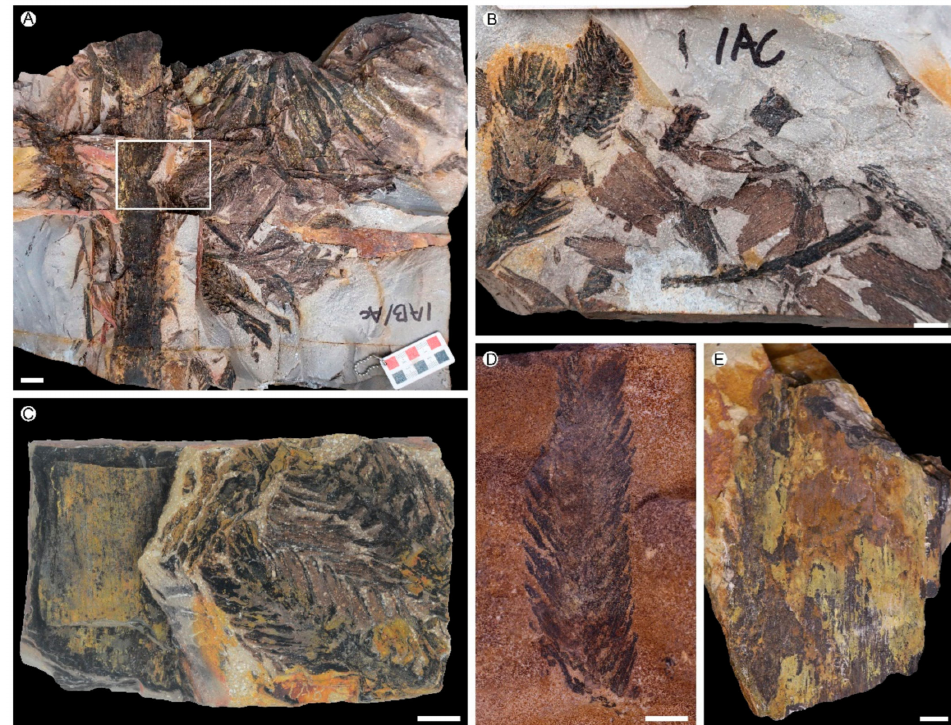
Figure 3. Tingia unita from Wuda Coalfield, Inner Mongolia. ( A ) Overall morphology of T. unita , both compound leaves and strobili are directly attached on the same stem, scale bar = 2 cm. ( B ) showing the large pinnules and stribilus, scale bar = 1 cm. ( C ) Enlargement of the area within white rectangular frame in ( A ), showing the stem part with anatomy examined, scale bar = 1 cm. Collection number: PB201151. ( D ) Showing the strobili, scale bar = 1 cm. Collection number: PB201695. ( E ) Another part of the stem of T. unita was anatomy examined, scale bar = 1 cm. Collection number: